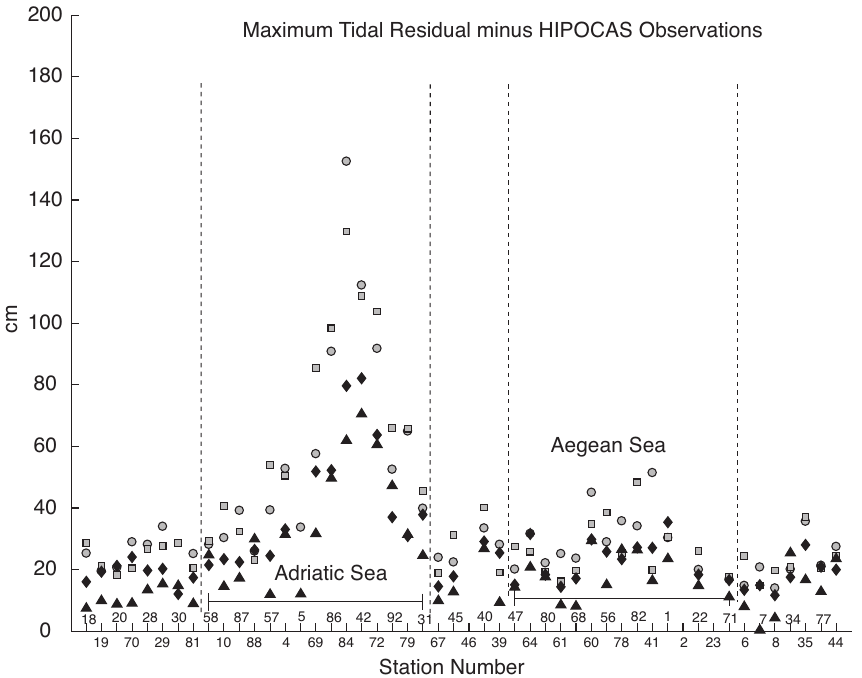
Figure 5. As Figure 3 for the eastern Mediterranean tide-gauges. Figure 5(continued). As Figure 3 for the eastern Mediterranean tide-gauges. Fig. 5. As Fig. 3 for the eastern Mediterranean tide-gauges.